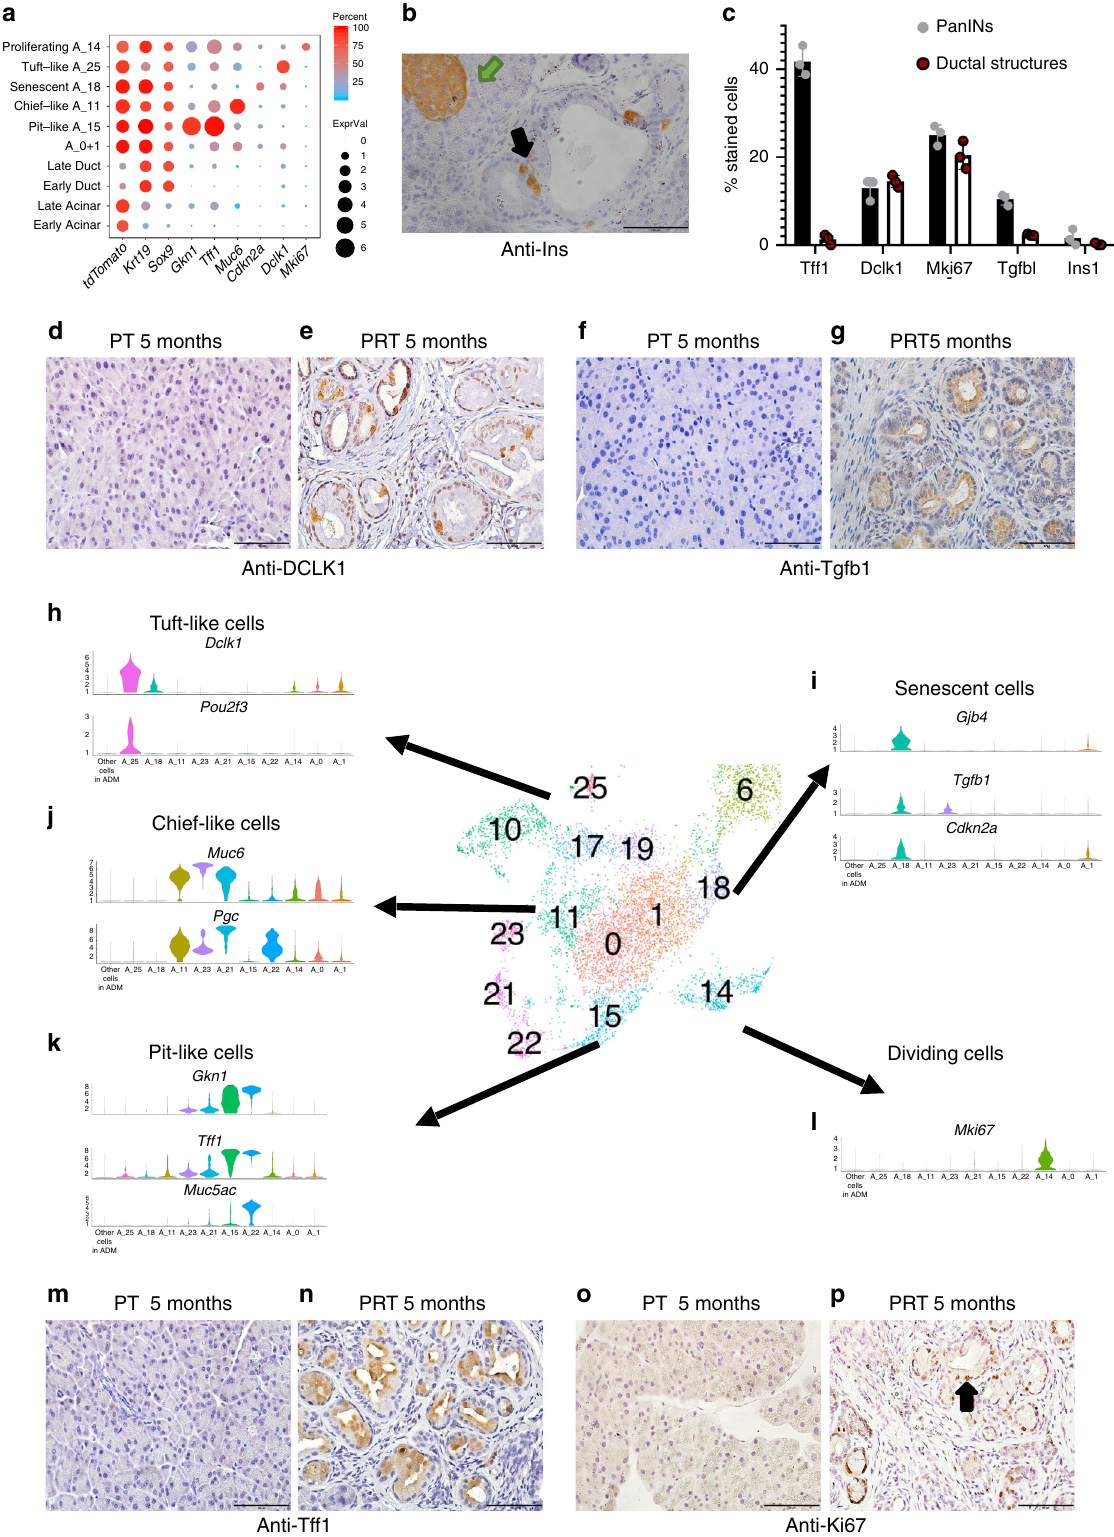
Supplementary Data 9). Stomach pit-like cells and senescent cells were enriched in PanIN lesions and most of these stained cells contained mucin (Fig. 4f, g, m, n), while tuft-like cells and proliferating cells could be detected in both ductal structures and PanINs (Fig. 4c and Supplementary Fig. 7h, i). Since it is